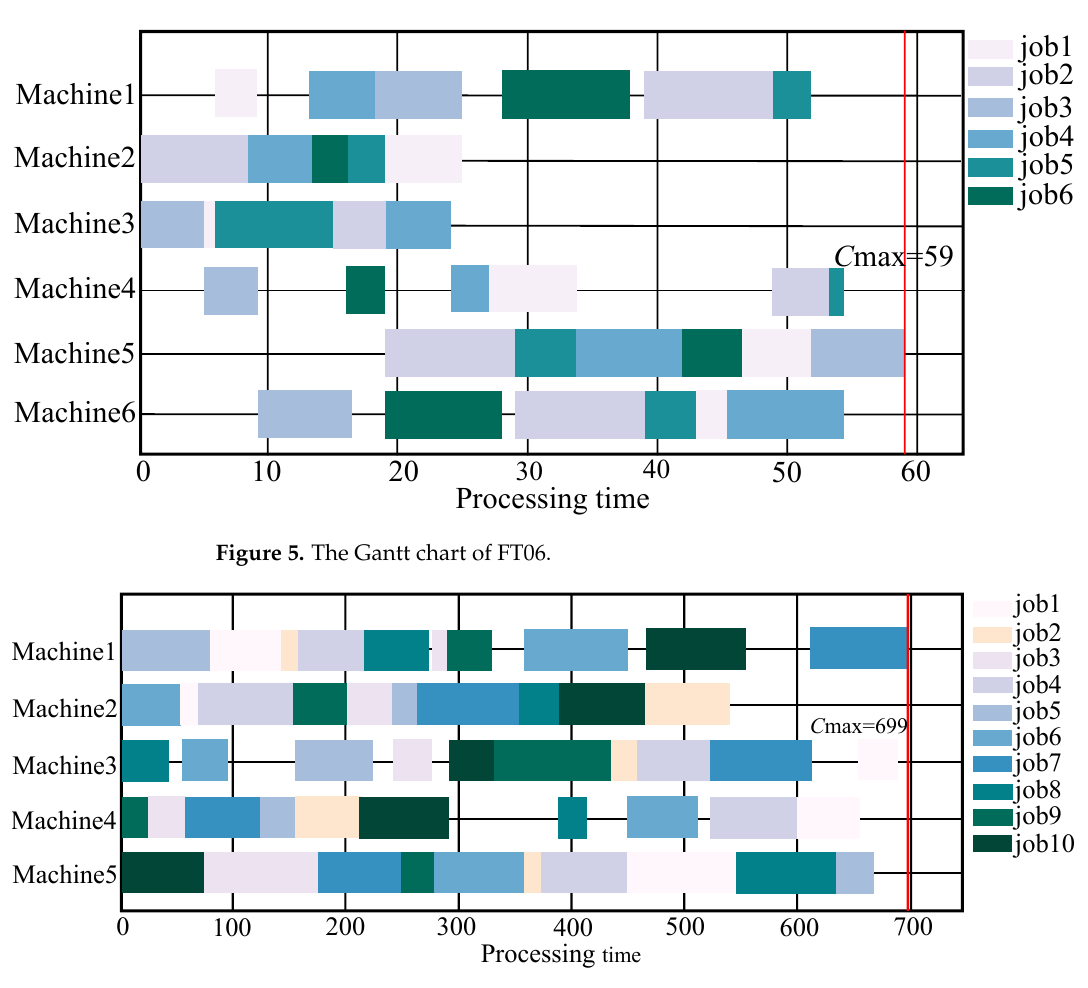
Figure 6. The Gantt chart of